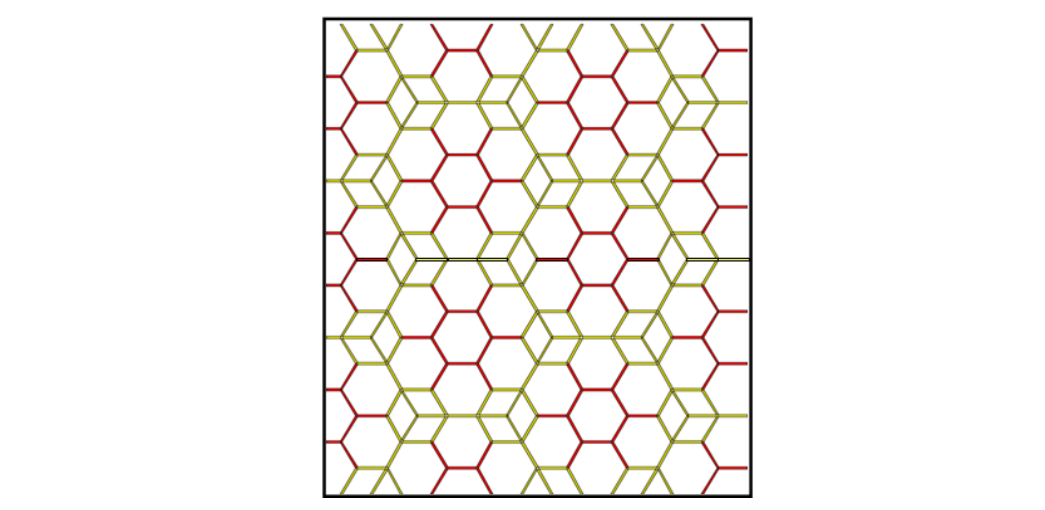
Figure 7: 2D model of a hierarchical polycrystal (CZM interface elements are shown in yellow and red, at the different scales).